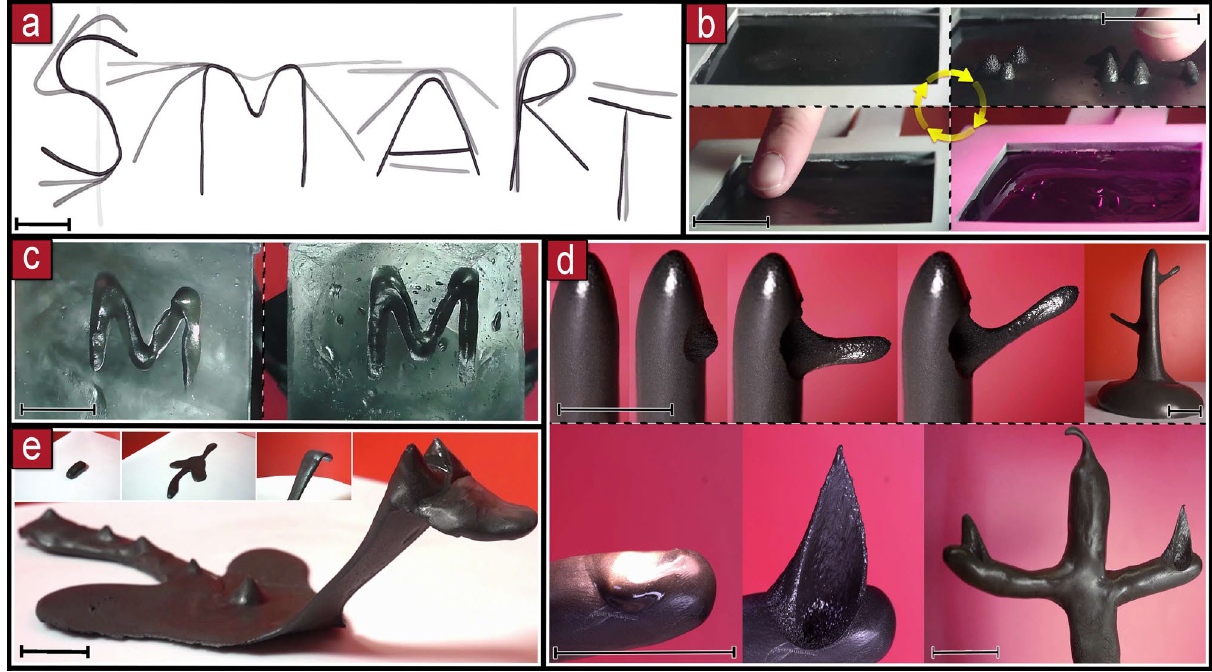
Figure 4. Complex manipulation. (a) Forming letters with 1D filament. (b) Reversible Braille patterns on a sheet. (c) Embossed letter M on a sheet. (d) Branching. (e) Sculpting in 3D. Scale bars are 3 cm.